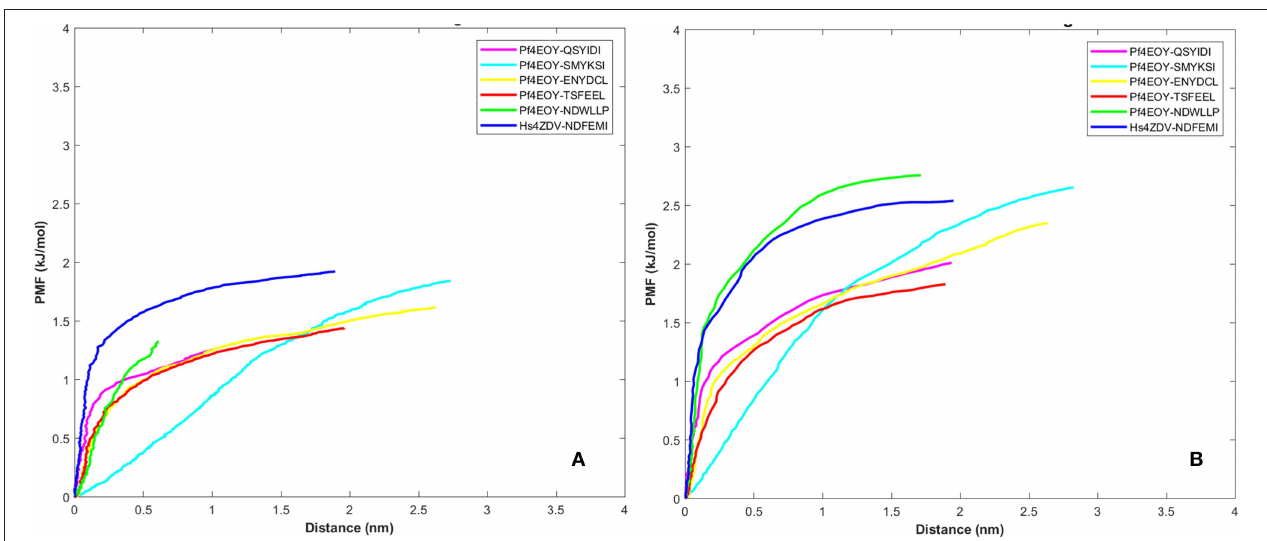
FIGURE 9 | Potential mean force profiles computed and plotted for the AIM/LIR— Pf Atg8/ Hs LC3 complexes at pull velocities (A) 0.010 nm/ns and (B) 0.025 nm/ns for the LIR motifs (i) Pf Sec62 QSYIDI (magenta), (ii) Pf Sec62 SMYKSI (cyan), (iii) Pf Sec62 ENYDCL (yellow), (iv) Pf Sec62 TSFEEL (red) and (v) Pf Atg3 NDWLLP (orange) LIR motifs bound to Pf Atg8 and (vi) Hs Sec62 NDFEMI (blue) bound to HsLC3.